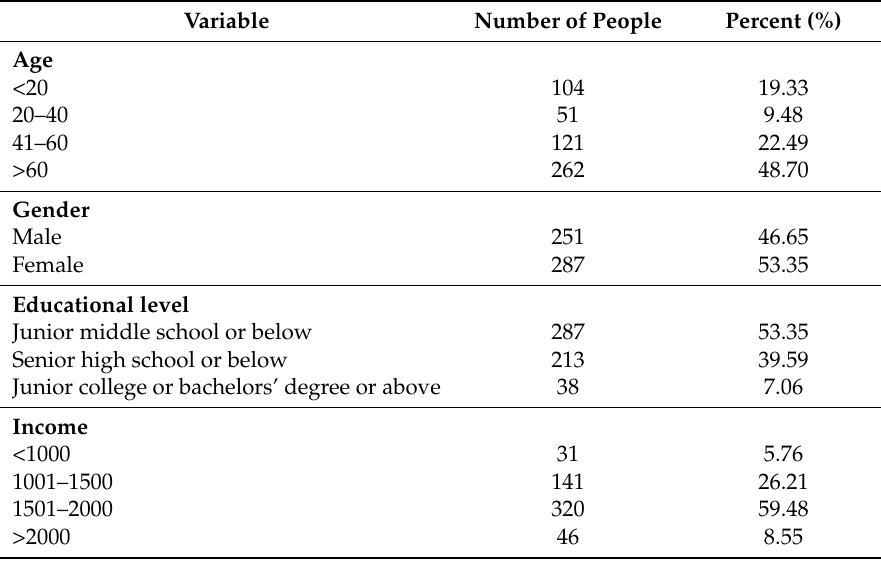
Table 1. The social-demographic of the